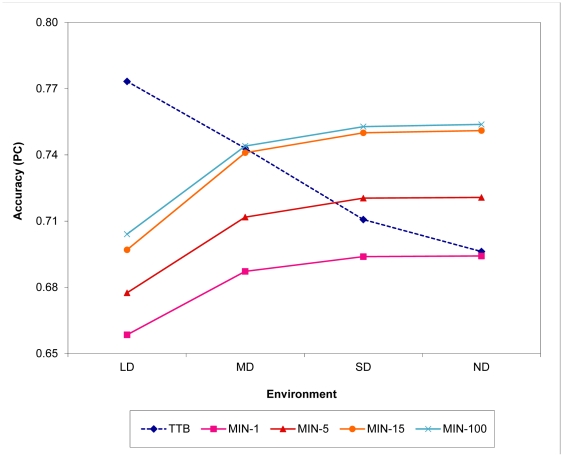
Results from Study 1: group size.Note that there was no effect of group size on a take-the-best (TTB) group's performance in this set of simulations, because the group was assumed to be totally homogeneous. MIN-1, MIN-5, MIN-15, and MIN-100 stand for a minimalist group with 1, 5, 15, and 100 agents, respectively. Environments differed in their distribution of cue validities: LD, large difference; MD, medium difference; SD, small difference; ND, no difference. PC: Percentage correct.